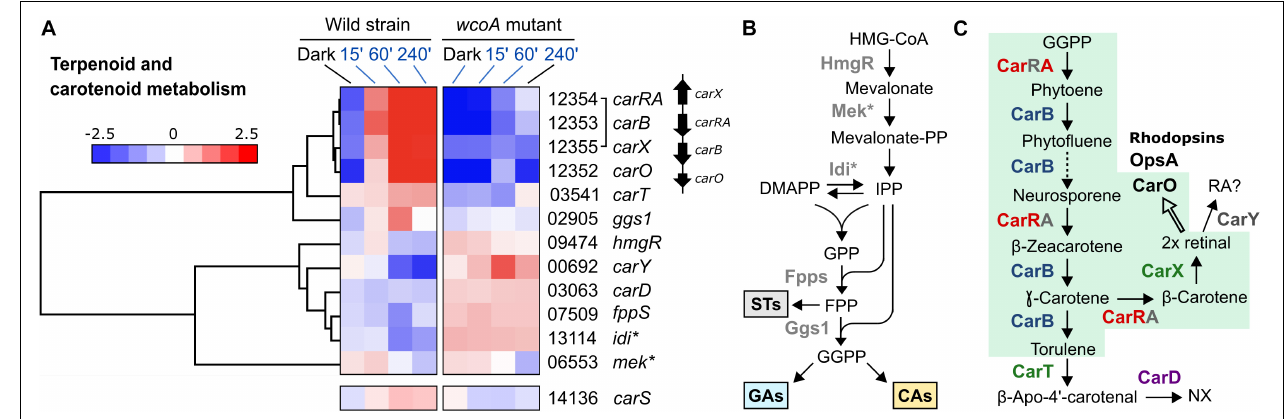
FIGURE 7 | Analysis of the genes involved in carotenoid biosynthesis. (A) Hierarchical heatmaps on the effect of illumination and/or the wcoA mutation on the mRNA levels of the genes of the carotenoid pathway and heatmap of the regulatory gene carS . FFC1_ numbers of the genes, and the names given in the literature, are indicated on the right. The asterisk indicates unpublished functions in F. fujikuroi , here inferred from its similarity to enzymes in other species. (B) Identification of gene functions in the early steps of terpenoid biosynthesis. STs, sterols; GAs, gibberellins; CAs, carotenoids. (C) Identification of gene functions in F. fujikuroi carotenoid metabolism. The green area indicates the steps involving proteins of the car cluster. The dotted arrow indicates more than one reaction. The thick arrow indicates the use of retinal as cofactor of